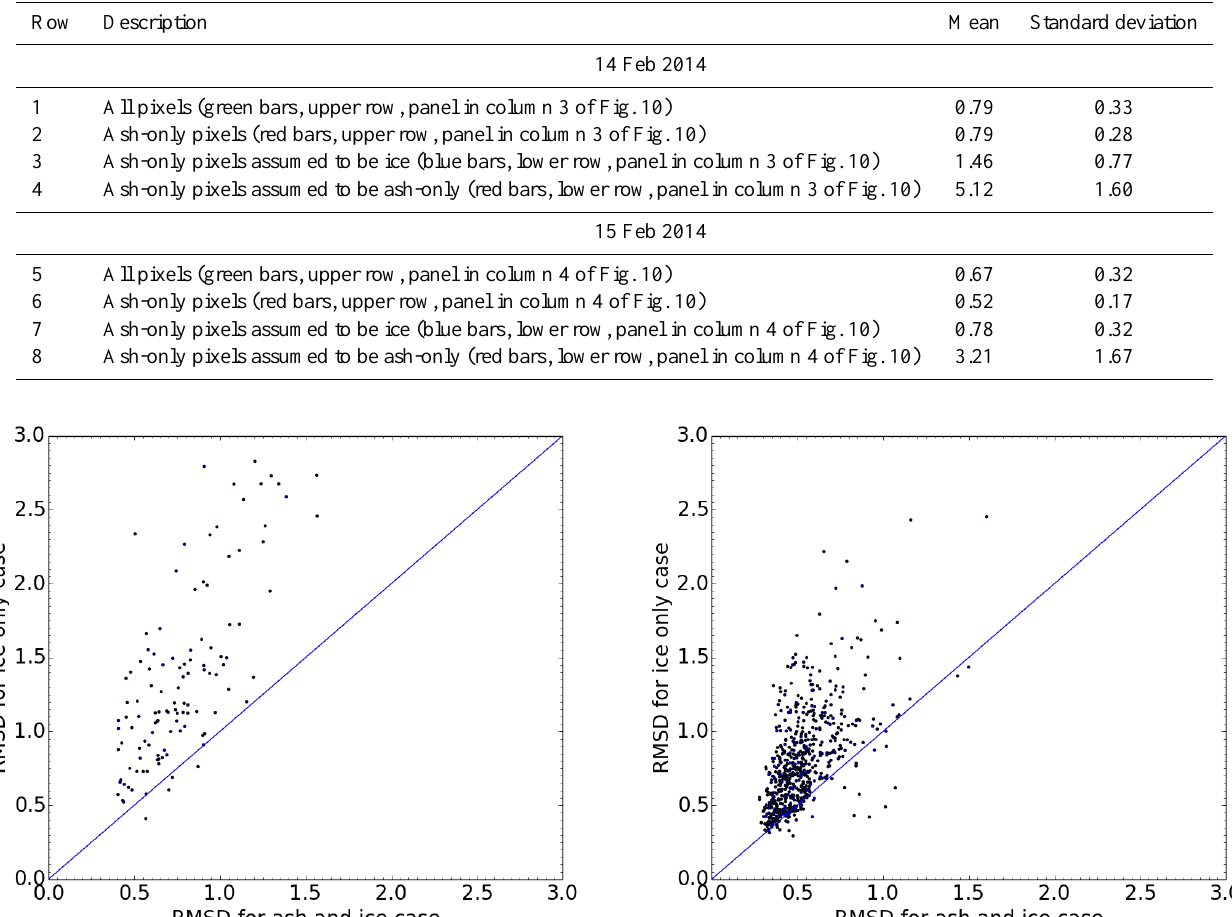
Figure 11. The RMSD for the ash and ice case vs. the ice-only case for 14 February 2014 (left panel) and 15 February 2014 (right panel).